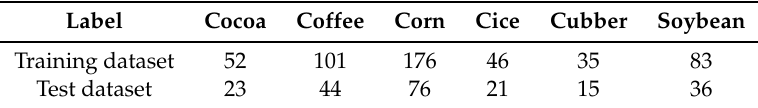
Table 7. The statistics of text classification dataset.